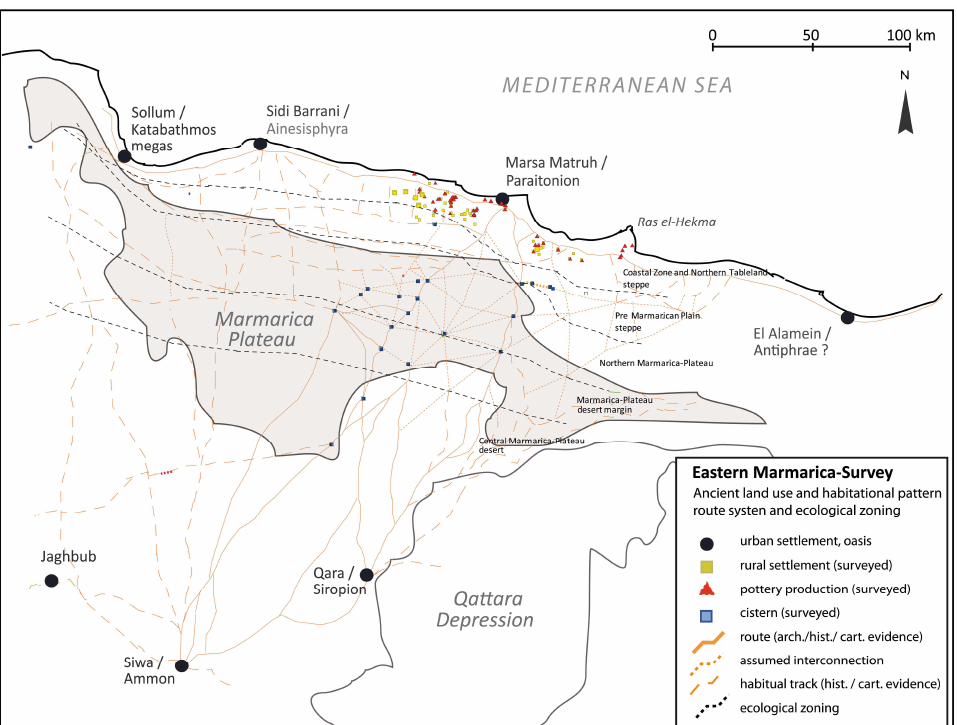
Figure 10. Map of the eastern parts of Marmarica showing habitational and land use patterns, production areas, and the route system in the ecological zoning. (Minor findspots like campsites or fields cannot be displayed on this scale.). Map: A.-K. Rieger, T. Vetter. The first issue for human, faunal, or floral life in Marmarica was the scarcity of water and the